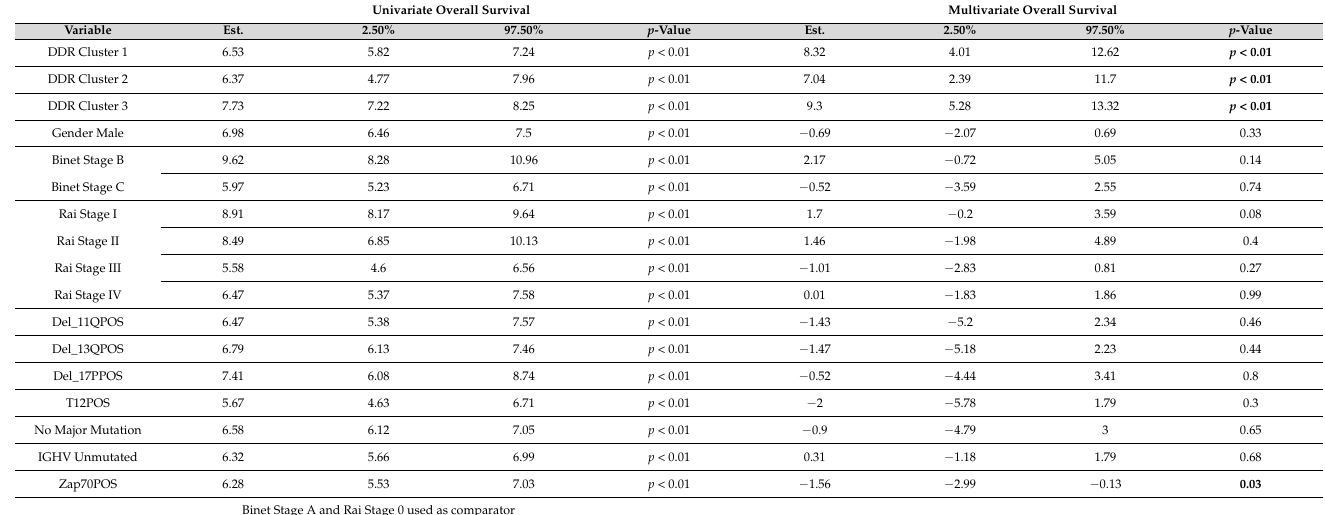
Figure 4. Effect of DDR protein cluster membership on the outcome for different treatments. Kaplan– Meier plots of the association between the three DDR protein clusters on overall survival for patients treated with the fludarabine – cyclophosphamide – rituximab (FCR) regimen ( Left ), with a Bruton Tyrosine Kinase (BTK) inhibitor ( Center ), or with the BCL2 inhibitor venetoclax ( Right ) are shown. For those treated with FCR, C1 patients had shorter OS compared to C3 patients. Notably, the number of FCR-treated C2 patients was too small to draw conclusions. For BTKi, C2 was significantly inferior to C1 ( p = 0.0036) or C3 ( p = 0.000019) but C1 and C2 were statistically similar. DDR cluster membership was not prognostic for those treated with venetoclax. Table 2. Univariate and Multivariate Analysis. Variables that were statistically prognostic of survival in univariate analysis, at a p -value of < 0.01 to account for multiple comparisons, are shown on the left side. This includes membership in DDR clusters 1, 2, or 3. These variables were then simultaneously compared in multivariate analysis with only the DDR protein cluster membership and ZAP70 status remaining as significant independent predictors of the